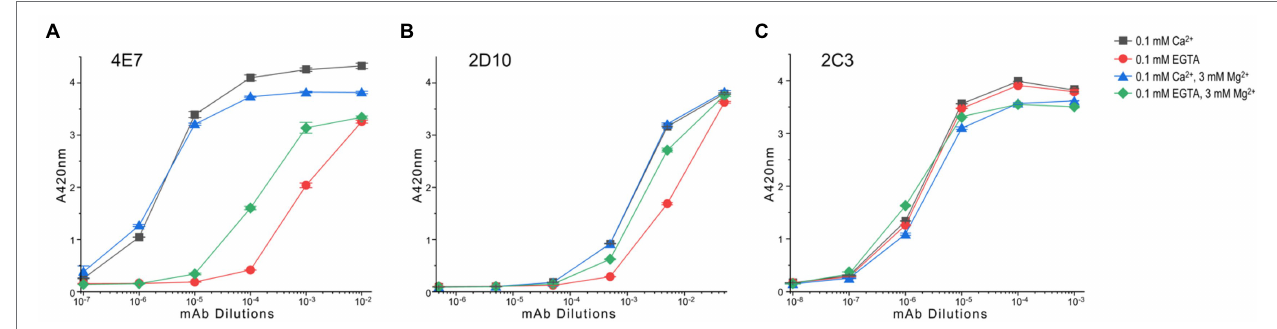
FIGURE 5 | Conformational effect of Ca 2+ and/or Mg 2+ binding to fast TnC detected in microtiter plate ELISA. (A) The ELISA titration curves show that mAb 4E7 against the N domain of fast TnC exhibits a low affinity in the metal-free condition. The presence of Mg 2+ , which binds to the C domain sites, significantly increased the affinity of mAb 4E7, indicating an effect on the N-domain conformation. Binding of Ca 2+ to the N-domain sites in the presence of 3 mM Mg 2+ further increased the affinity of mAb 4E7. The highest affinity of mAb 4E7 was seen in the four-Ca 2+ state, indicating that the occupations of the C domain sites by Ca 2+ or Mg 2+ have different conformational effect on fast TnC. (B) mAb 2D10 against the C domain of fast TnC shows higher affinities in the four-Ca 2+ or Ca 2+ + Mg 2+ state than that of Mg 2+ alone while the metal free-apo state has the lowest affinity, indicating both ions bind to the C-domain with similar conformational effect whereas Ca 2+ binding to the N domain increases the affinity for mAb 2D10. (C) mAb 2C3 detected a conformation-independent epitope that displays similar affinity for fast TnC in the presence or absence of Ca 2+ and Mg 2+